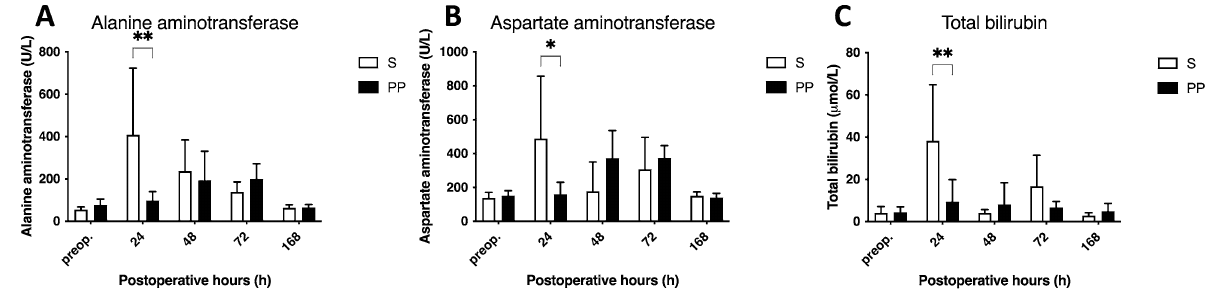
Figure 2. Changes in liver function laboratory parameters. Level of alanine aminotransferase ( A ), aspartate aminotransferase ( B ) and total bilirubin ( C ) preoperatively (preop., 0 h), and at 24 h, 48 h, 72 h, and 168 h after associating liver partition and portal vein ligation for staged hepatectomy (ALPPS) (N = 6 per time point per group). * p < 0.050, ** p < 0.0010 physical prehabilitation (PP) versus sedentary (S).